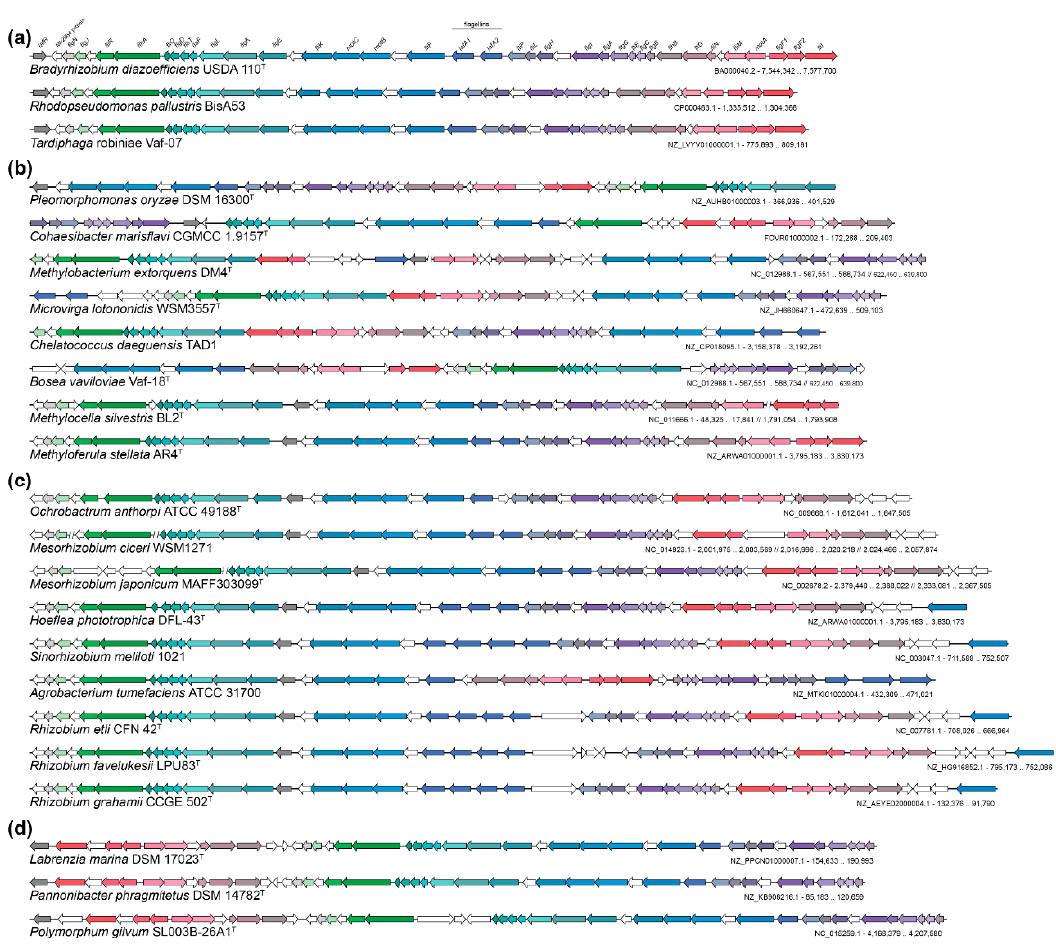
Figure 3. Synteny of the lateral flagellar system across representative Rhizobiales genomes and closest relatives outside Rhizobiales . ( a ) Synteny of the lateral flagellar systems of Bradyrhizobium , Rhodopseudomonas and Tardiphaga type strain species genomes. ( b ) Synteny of the lateral flagellar systems of diverging Rhizobiales genomes belonging to Pleomorphomonas, Cohaesibacter, Methylobacterium, Microvirga , Chelatococcus , Bosea , Methylocella and Methyloferula species. ( c ) Synteny of lateral flagellar systems of genomes belonging to Ochrobactrum , Mesorhizobium , Hoeflea , Sinorhizobium , Agrobacterium and Rhizobium species. ( d ) Synteny of the lateral flagellar systems of closest relative genomes outside Rhizobiales belonging to Labrenzia , Pannonibacter and Polymorphum species of the Rhodobacteraceae family. White arrows indicate hypothetical or unknown proteins or proteins with no involvement in flagellar biosynthesis or regulation. Species name, genome NCBI accs. no. and coordinates of the regions shown are specified under the syntenic representation of each genome.